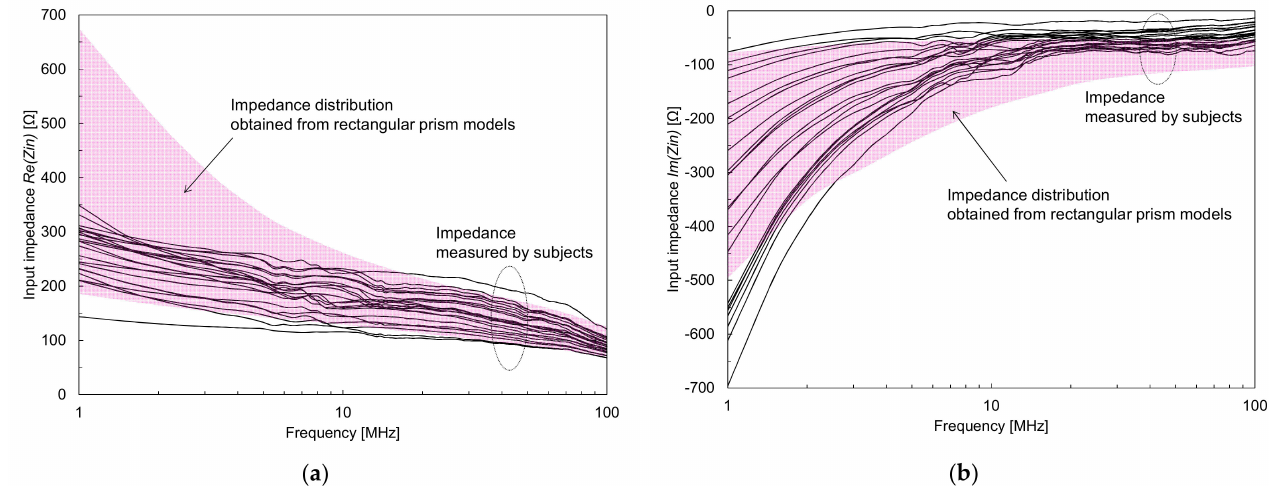
Figure 14. Comparison of input impedance characteristics obtained from measurement and from analysis: ( a ) Real component of input impedance characteristics; ( b ) imaginary component of input impedance